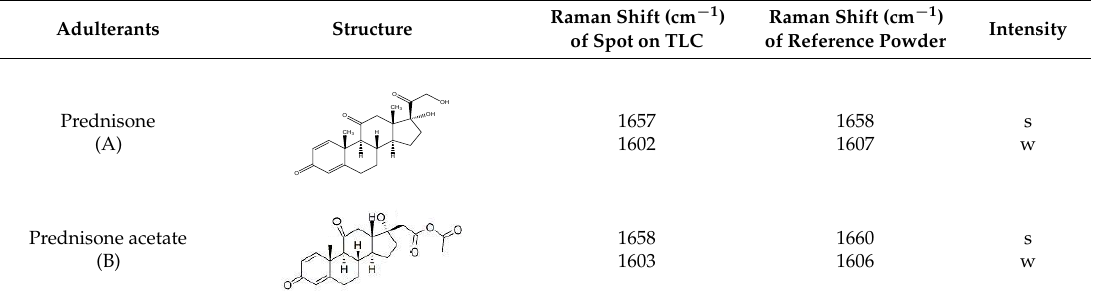
Figure 5. Raman spectra of reference substance solutions by TLC–SCRS (deposition amount of 10 μ g). A , B , C , D , E , F : prednisone, prednisone acetate, prednisolone, hydrocortisone, hydrocortisone acetate, and Table 1. Raman spectral characteristic peaks of the six reference substances. Table 1. Raman spectral characteristic peaks of the six reference substances.